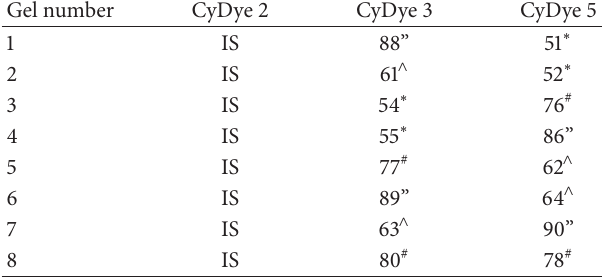
Table 1: Labeling scheme for 8 gels: the internal standard (IS) and each analyzed sample were labeled with CyDye 2, 3, or 5 as shown in the table. The internal standard is generally the mixture of the same portions of all analyzed